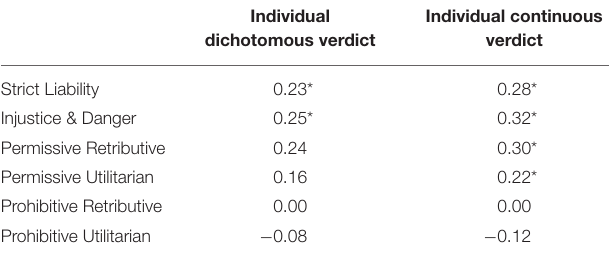
TABLE 2 | Bivariate relationships between attitudinal measures and outcome